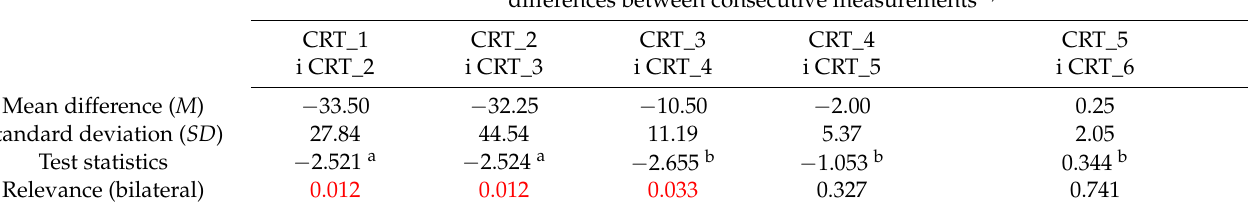
Table 3. CRT – descriptive statistics and statistical significance of differences.